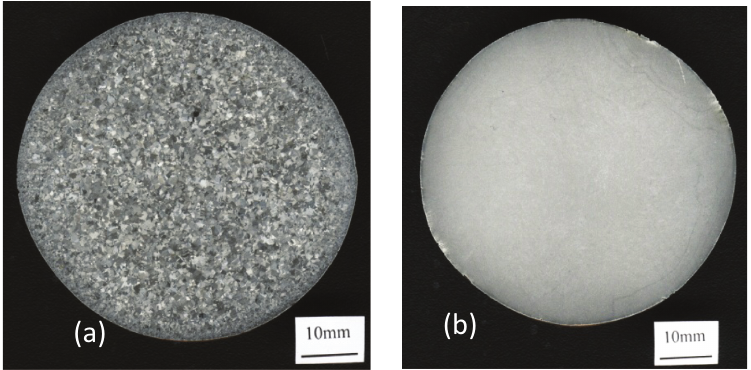
Figure 2: The macrostructure of the semi-finished Ti6Al4V material before rolling with pre-heat treatment at 1150 ℃ for 2 h (a), the forged status without pre-heat treatment (b).